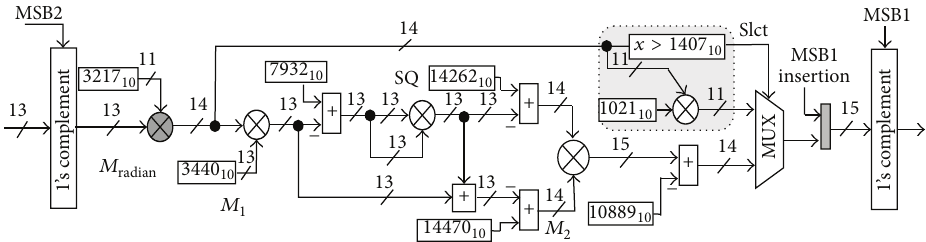
Figure 8: Architecture of the proposed algorithm. 𝑀 : radian multiplier, 𝑀 1 : constant coefficient multiplier, 𝑀 2 : variable coefficient radian multiplier, 𝑆𝑄 : squarer, MSB 1 : first most significant bit, and MSB 2 : second most significant bit.